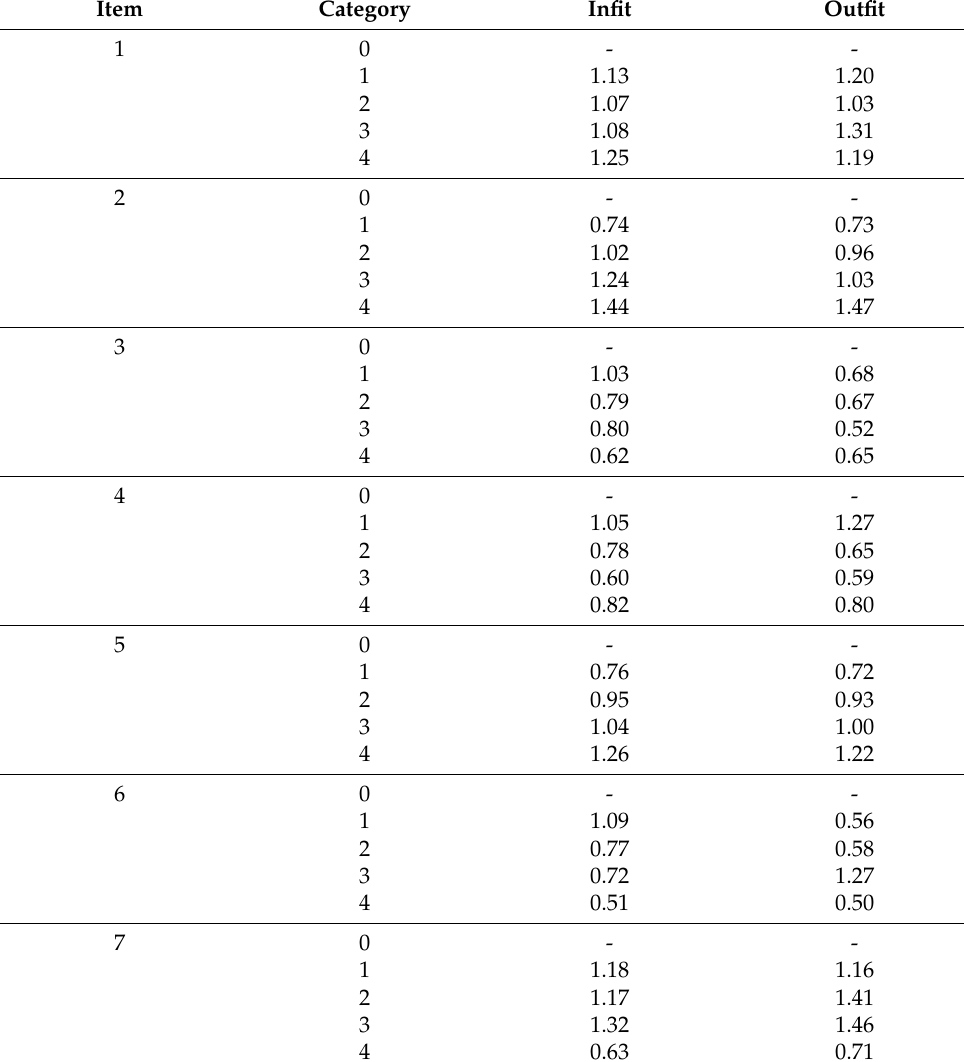
Table 4. Item suitability